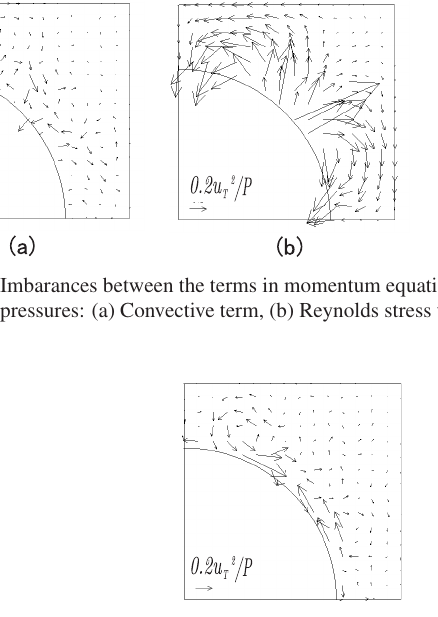
Fig. 7 Non-conservative components of Reynolds stress